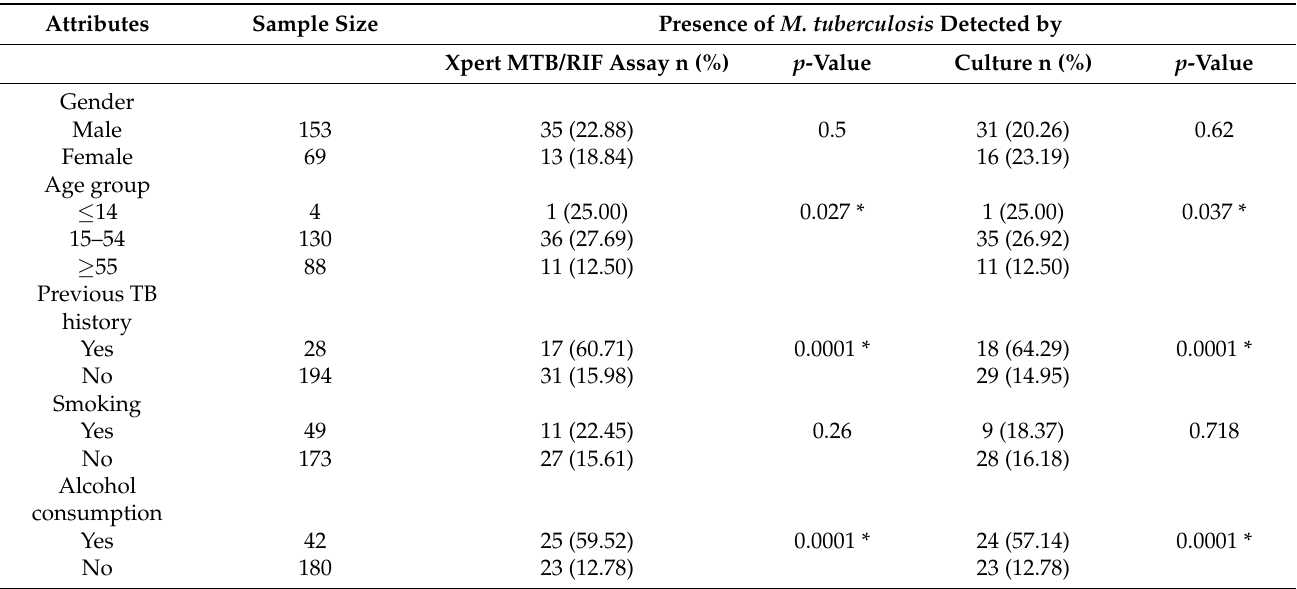
Table 2. Distribution of tuberculosis infection, with respect to various